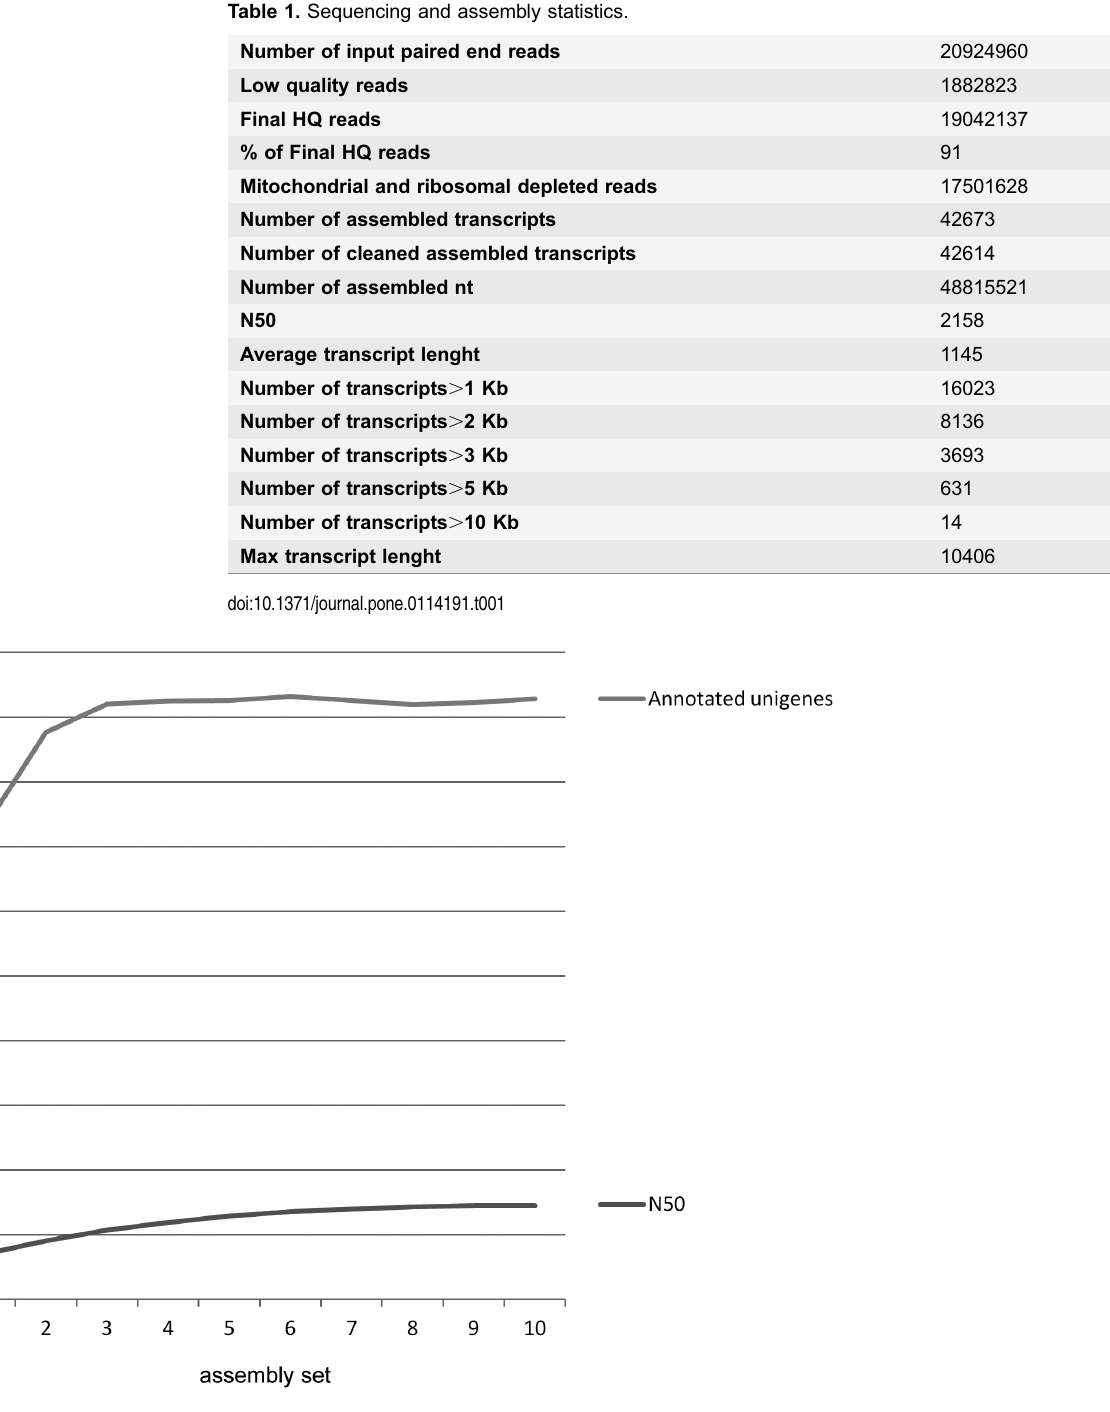
Figure 2. Coverage assessment of the MEET data set. The number of assembly obtained with a progressively large sub-samples of randomly selected raw reads (2 M for each step) is plotted against the number of annotated unigenes by FastAnnotator software (using NCBI nr database) and the N50 value. The number of annotated unigenes reached a plateau after about 8 M reads (green line) while the N50 unigene value continued to increase approximately linearly over the same range (red